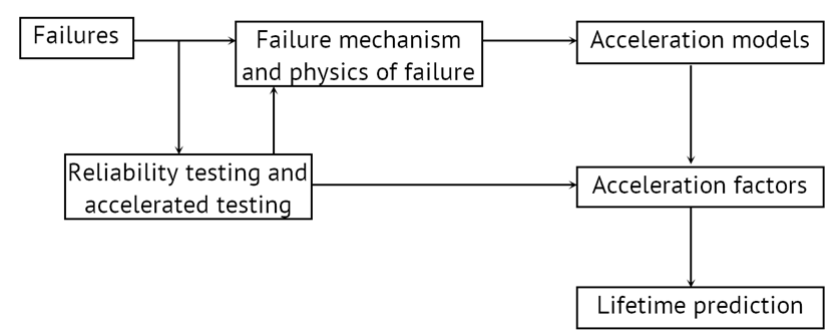
Figure 14. Lifetime prediction diagram (after [32 and 20]).